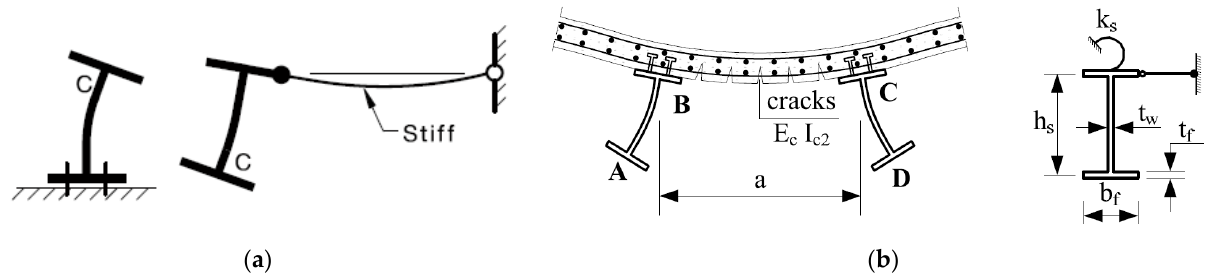
Figure 8. Approaches to weighting the geometric properties of the cross-section: ( a ) superficial way; ( b ) linear. Adapted from Carvalho, Rossi, and Martins [94].